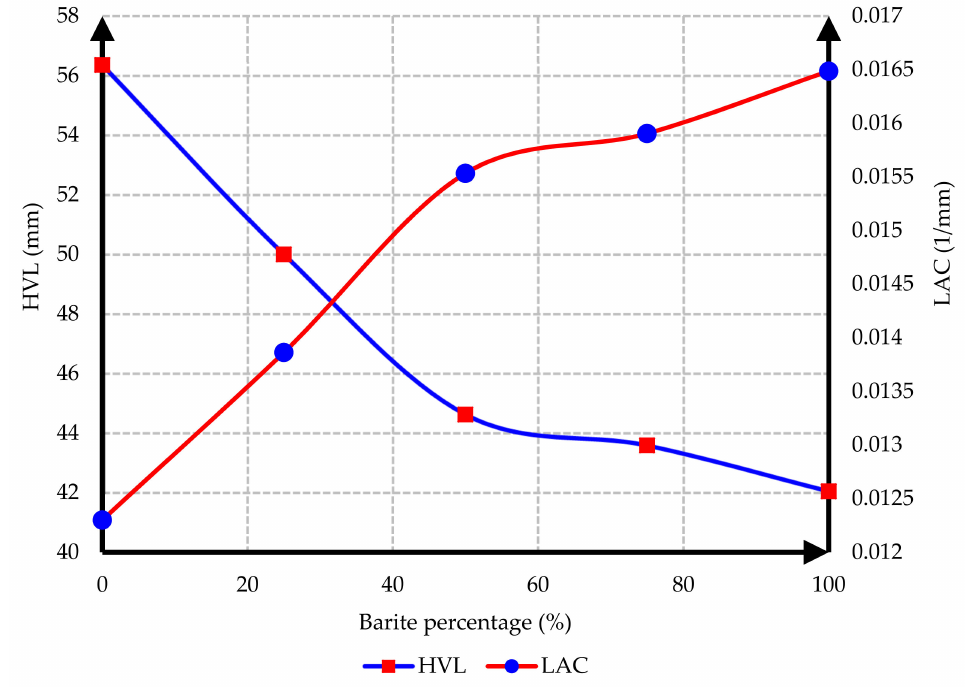
Figure 15. Interaction between the attenuation and the HVL for C35